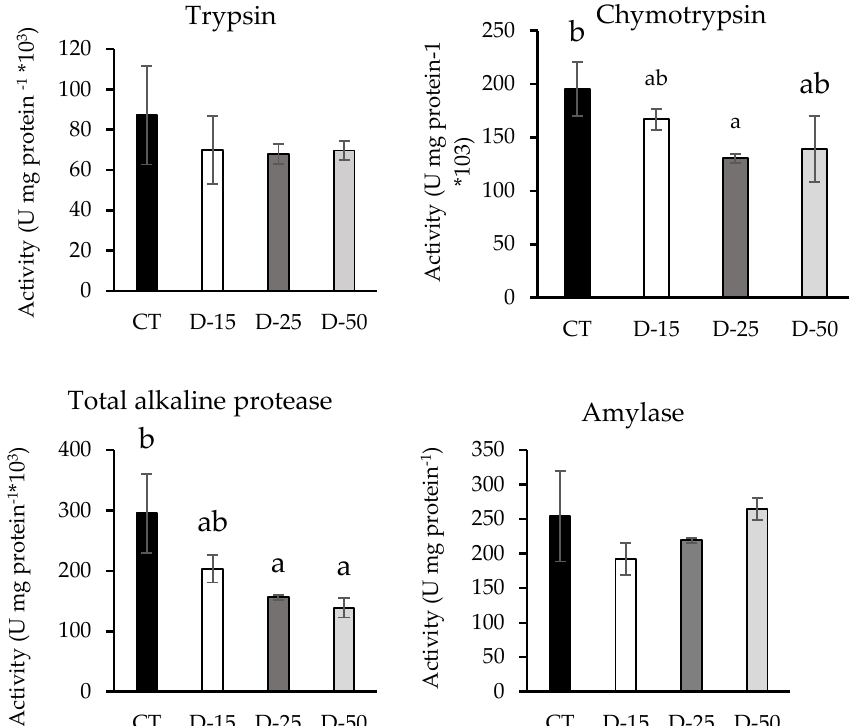
Figure 1. Enzyme activities measured in hepatopancreas extracts of L. vannamei fed with experimental diets for 70 days. Values are presented as mean ± SD ( n = 6). Values with different lowercase letters indicate significant differences among treatments ( p < 0.05).